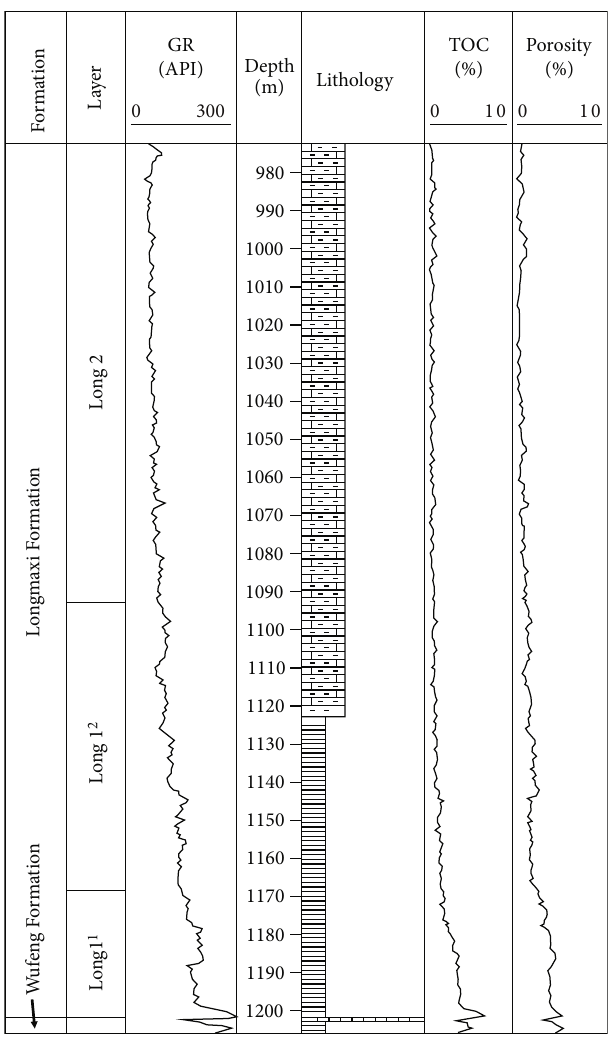
Figure 3: Typical lithological system of the Wufeng Formation and Longmaxi Formation in the Haiba Block (Well